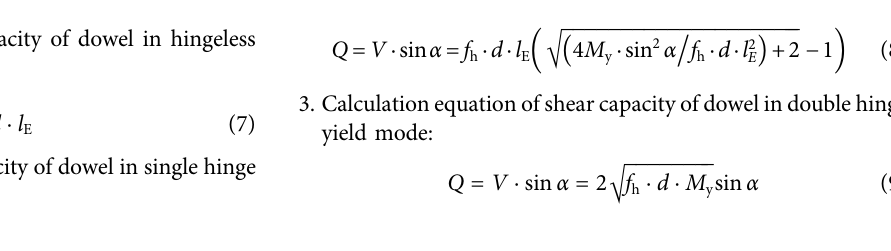
Frontiers in Materials |